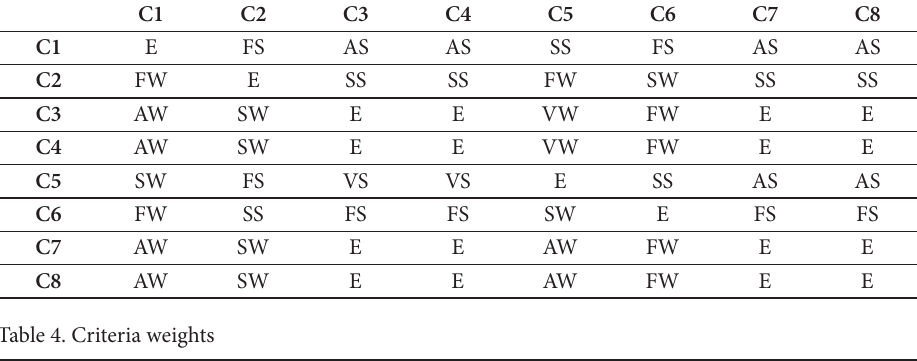
Table 3. Pairwise comparison matrix of criteria using linguistic terms